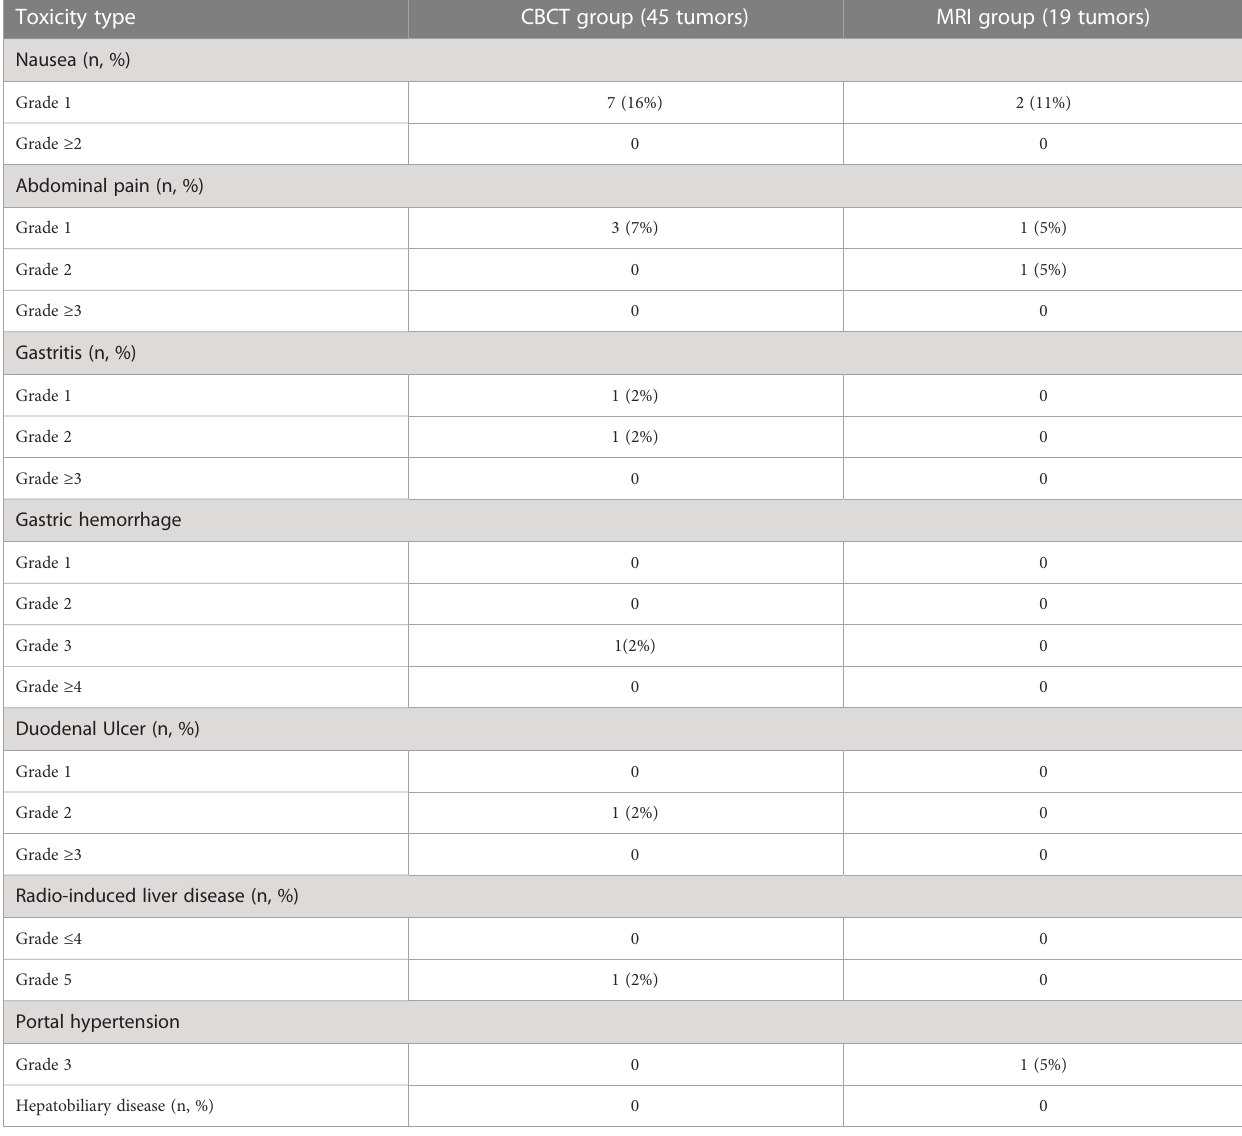
TABLE 1 Liver SABR toxicity in the CBCT and the MRI